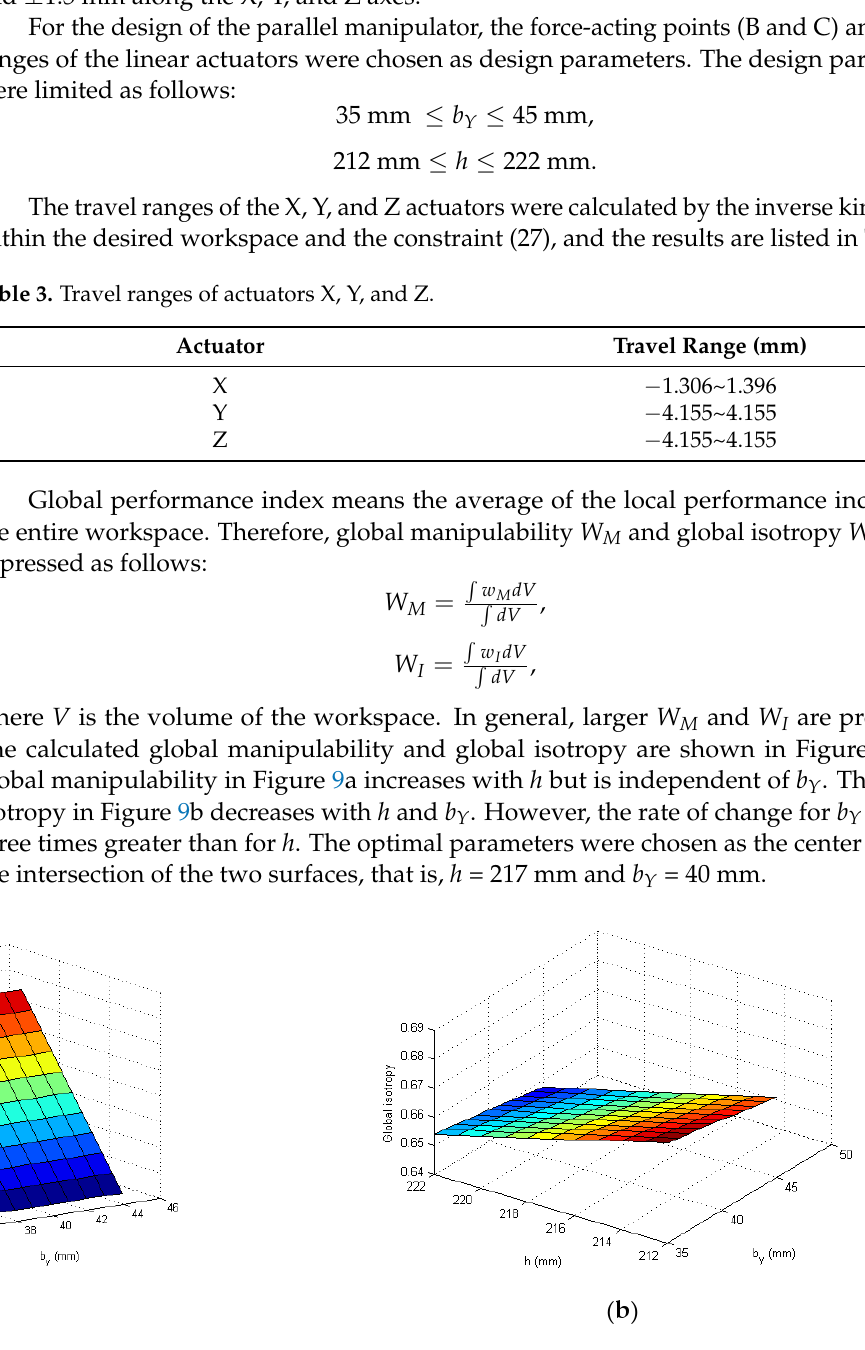
Figure 9. Global performance index: ( a ) global manipulability; ( b ) global isotropy.